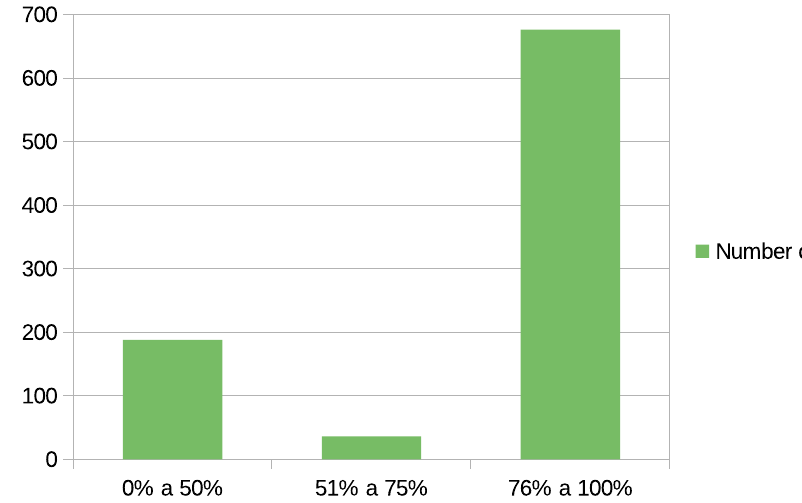
Figure 3. Number of Controls by Acceptance Percentage